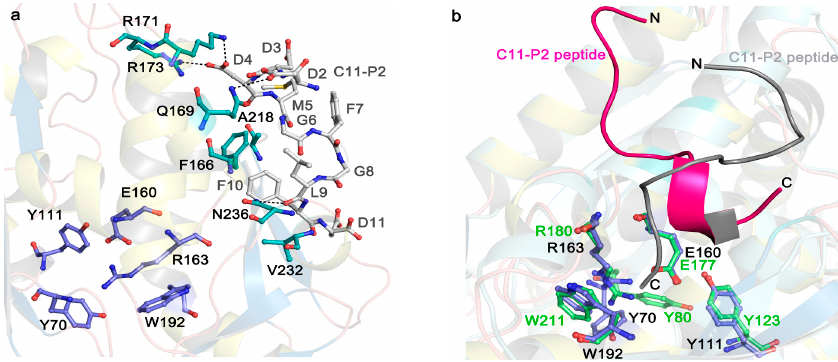
Figure 3. Stereo image on the active site and P2 binding mode of TCS (PDB code: 2JDL) and RTA (PDB code: 5GU4). ( a ) The active site and P2 binding pocket of TCS. The conserved active site residues in TCS are shown in purple sticks. The P2 binding residues are shown in cyan sticks. The C11-P2 peptide is shown as gray sticks. Hydrogen bonds are highlighted with black dash lines; ( b ) P2 peptide adopts distinct conformation for binding to TCS and RTA. The conserved active site residues in RTA are shown in green sticks. The magenta and gray colored C11-P2 peptides indicate the orientations of P2 peptide in binding to RTA and TCS, respectively.